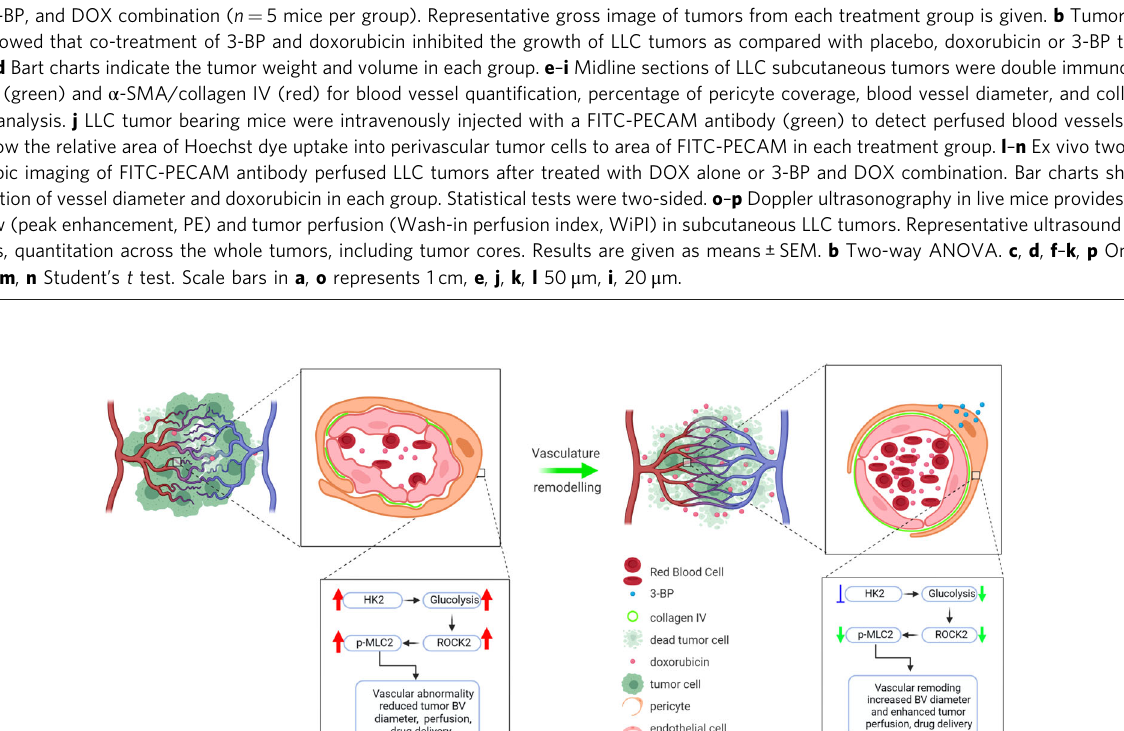
Fig. 7 Schematic diagram represents the role of pericyte-HK2-driven glycolysis in regulating tumor blood vessel abnormality via ROCK2-MLC2 mediated contractility. TPC up-regulates HK2-driven glycolysis to induce ROCK2-MLC2 mediated contractility, which in turn negatively regulates its blood vessel supporting role. Administration of HK2 inhibitor 3-BP induces MLC2-driven tumor vasculature remodeling to increase blood fl ow, tumor perfusion, blood vessel diameter as well as chemotherapeutic drug delivery and ef fi cacy against tumor growth, while reducing tumor hypoxia without affecting blood vessel density and pericyte